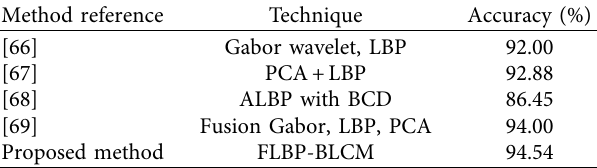
Table 7: Evaluation of the prior approach with the proposed approach using classification performance